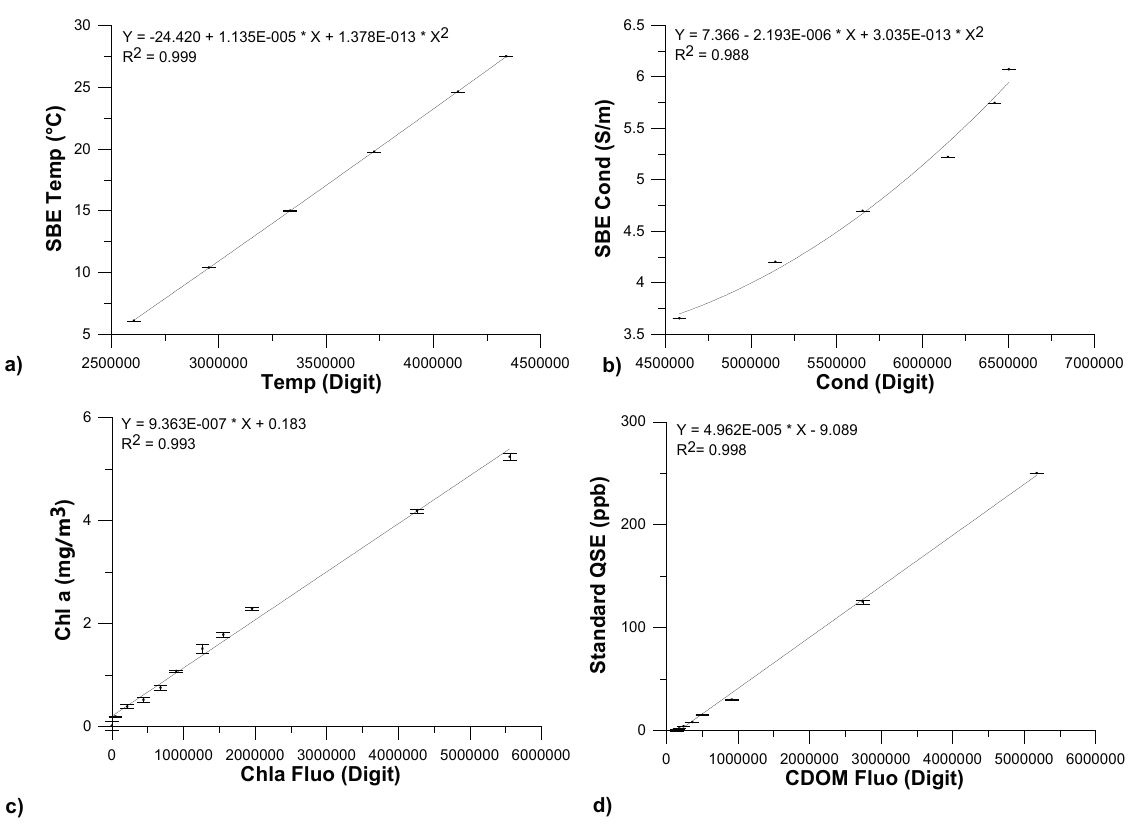
Figure 7. Examples of ( a ) temperature; ( b ) conductivity; ( c ) Chla fluorescence and ( d ) CDOM fluorescence calibration